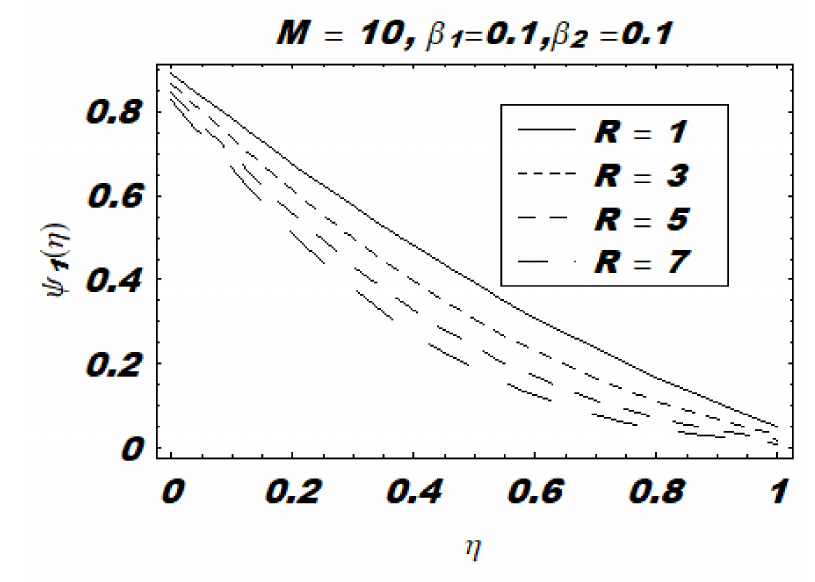
for the circular slider. 3